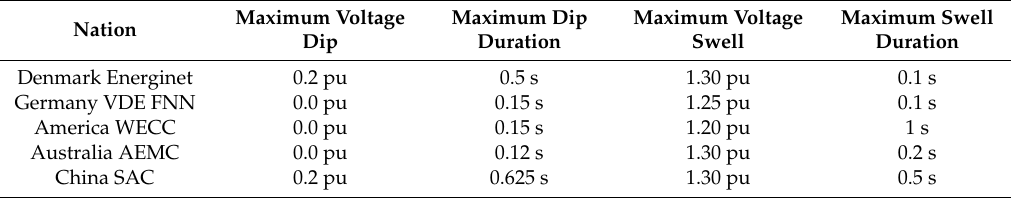
Table 1. Comparison of grid codes around the world.